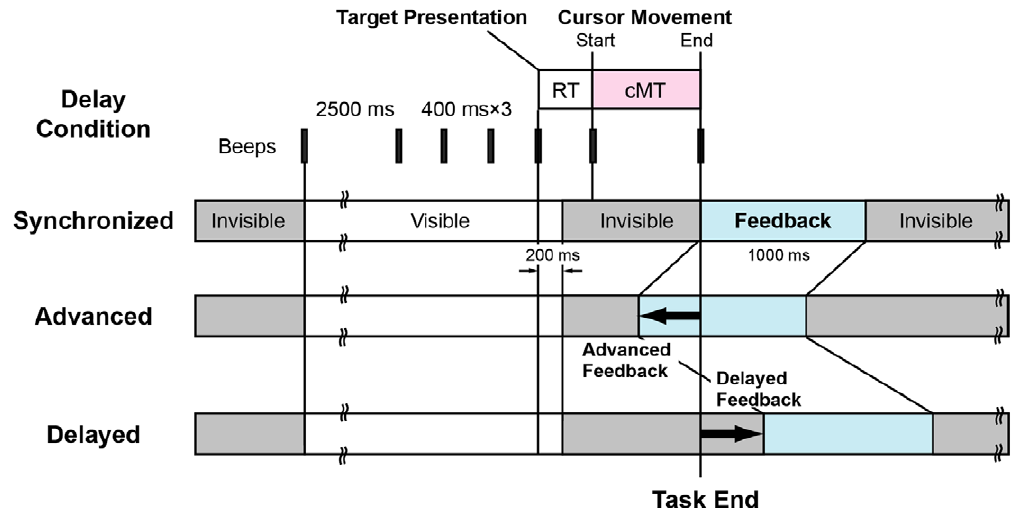
Figure 6. Task Schedule. Each trial started with a beep sound and the appearance of a target line. After a 2500-ms pause, three intermediate-tone beeps were given at 400-ms intervals, followed by a high-tone beep, and the appearance of a target at a random position on the target line. The subject began wrist movement immediately after target presentation so as to hit the target with a cursor. The computer program monitored wrist movements, detected their peak angular velocity and initiated the cursor movement. Timing of visual feedback differed among the delay conditions. Under some conditions, visual information was given later than task-end, while under the other conditions, it was given in advance of task-end.